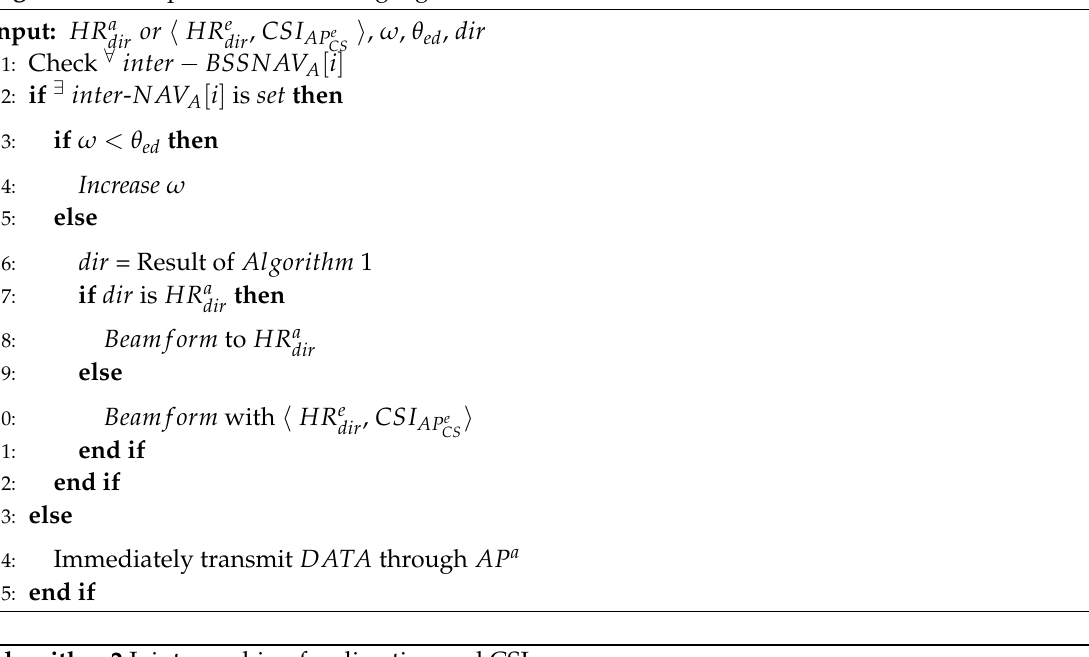
Algorithm 2 Joint searching for direction and CSI